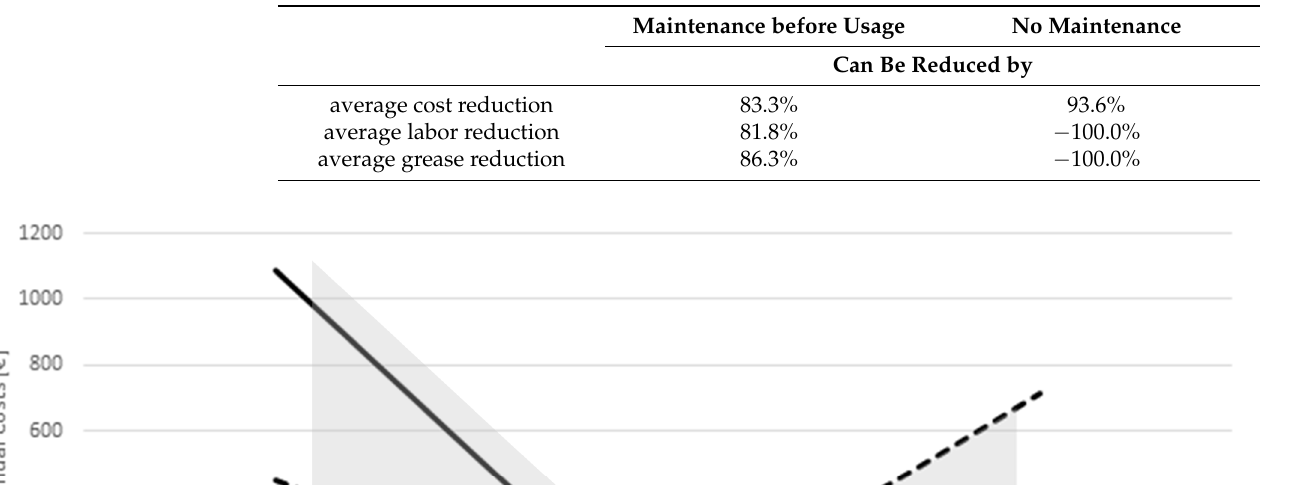
Table 7. Average reduction of costs, labor time and grease for all three machines from the extreme scenarios to when maintenance is carried out as specified by the manufacturer; additional assumption for the feed mixer: maintenance is carried out once a week instead of daily.